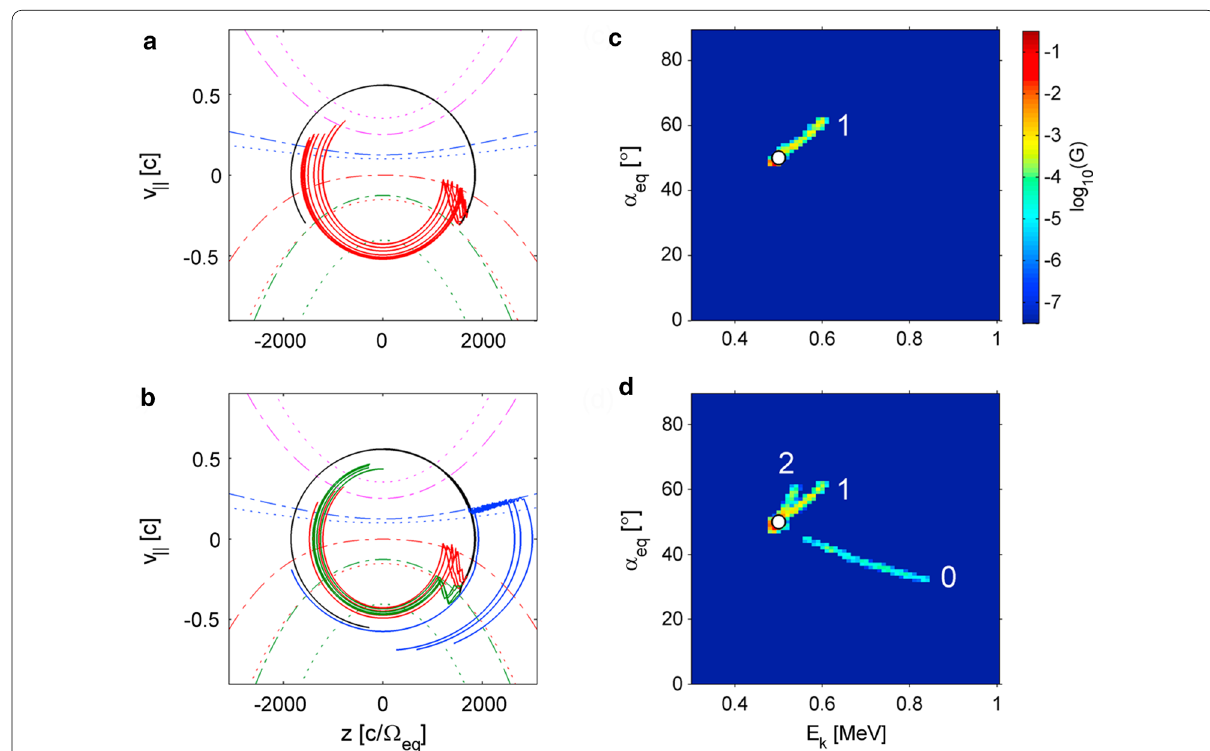
Fig. 14 Trajectories of trapped resonant electrons. Acceleration of electrons through nonlinear trapping by a chorus wave with the wave normal angle parallel ( a , c ) and oblique ( b , d ) to the background magnetic field. In a , b , resonance velocities for n 0.5 � e ) and dotted lines ( ω 0.2 � e ). Going through the resonances, colors of the trajectories changes from black to blue, red, dash-dot lines ( ω = = 0,1,2 resonances. The numbers next to the branches of the Green’s functions represent the n -th resonances (after and green, corresponding to n = Hsieh and Omura